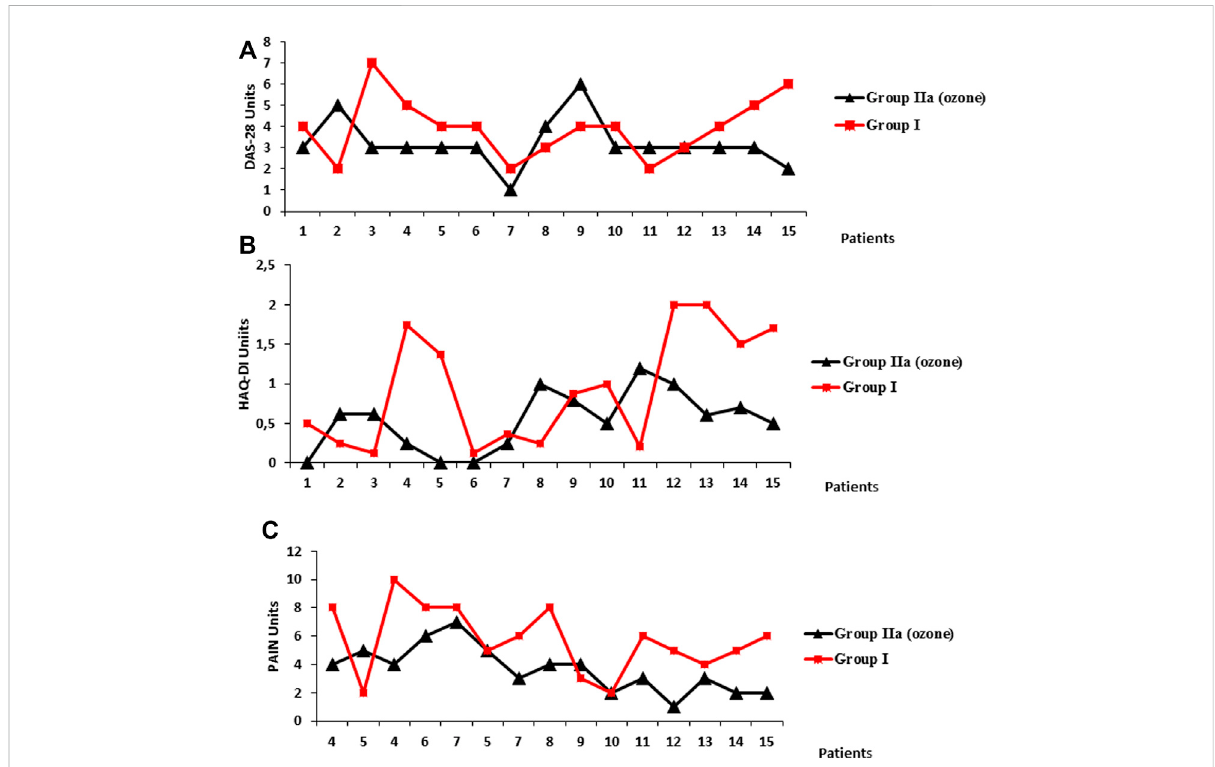
FIGURE 1 Clinical variables: (A) DAS28 (Disease Activity Score 28), (B) HAQ-DI (Health Assessment Questionnaire – Disability Index), and pain (C) (Visual Analogical Scale, VAS) in two groups of elderly patients (60 – 70 years (n = 30). Group I, without medical ozone (n = 15) and group IIa, rheumatoid arthritis+ comorbidities, n= 15,treatedwith medicalozone + methotrexate + ibuprofen + folic acid.Group I(same as group IIabut without medical ozone. DAS28, low activity ≤ 3.2; moderate activity > 3.2; and ≤ 5.1: high activity > 5.1 HAQ-DI, (+ > 1.25). Pain, Visual Analogical Scale (VAS) from “ 0 ” (minimum pain intensity) to “ 10 ” (maximum pain intensity). No pain was considered “ 0. ” Statistical analysis for the variables showed the following results:DAS28,groupIIa(endoftheexperiment)vs.groupI. 3 ±0.2vs. 5 ±0.4(p < 0.05)HAQ-DI,groupIIa(endoftheexperiment)vs.groupI. 0.64